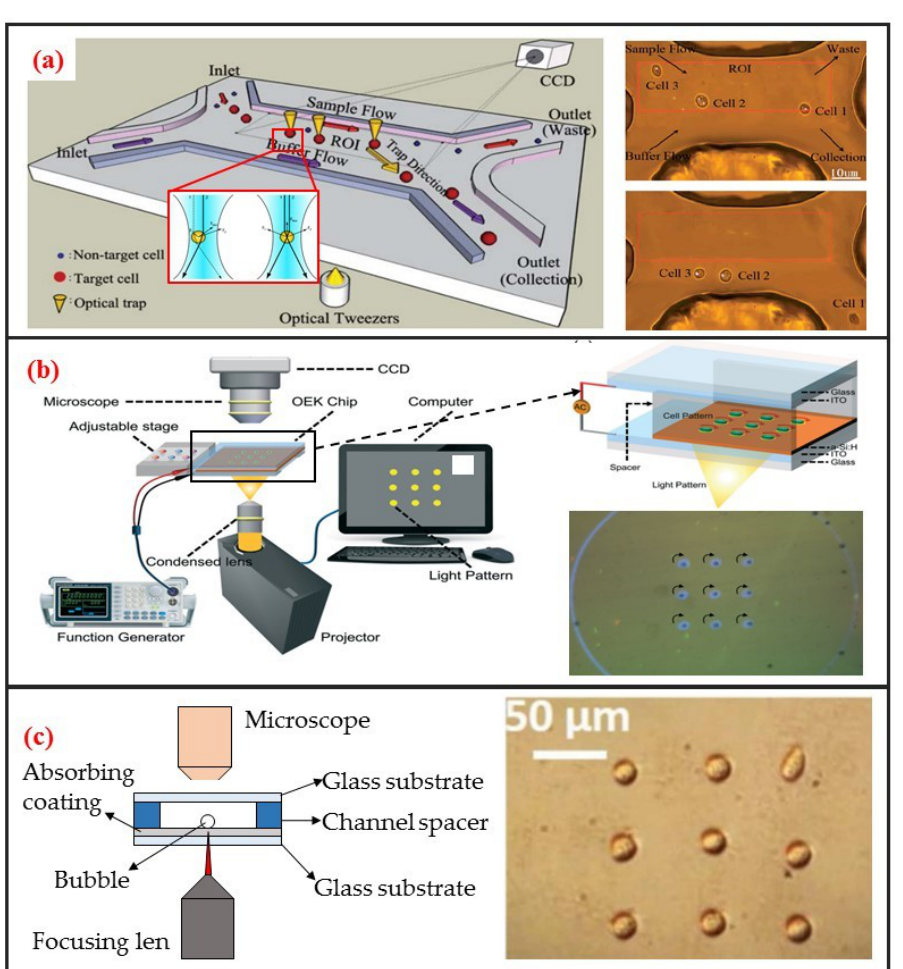
Figure 6. Optical single-cell manipulation methods and some designs. ( a ) Optical tweezer based single-cell sorting. Adapted by permission from Reference [12], copyright Royal Society of Chemistry 2011. ( b ) ODEP based single-cell array rotation. Adapted by permission from Reference [76], copyright Royal Society of Chemistry 2017. ( c ) Opto-thermocapillary based single-cell pattern. Adapted by permission from Reference [77], copyright Royal Society of Chemistry 2013.